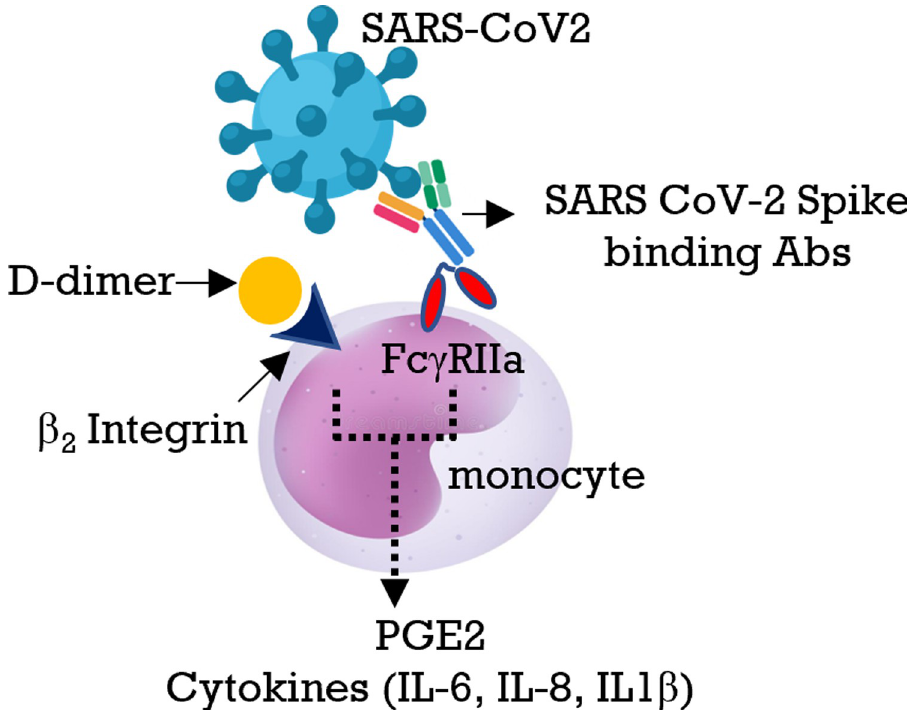
Fig 7. Model of PGE2 and cytokine production in monocytes activated with DD and IC. DD alone induces low levels of PGE2 and IL-6/IL-8 cytokines production in monocytes through β 2 integrin. This priming signal is then amplified by signaling from Fc γ RIIa triggered by immune complexes of SARS CoV-2 viral particles coated with SARS CoV-2 spike binding antibodies leading increased production of PGE2, IL-6, and IL-8 by monocytes.